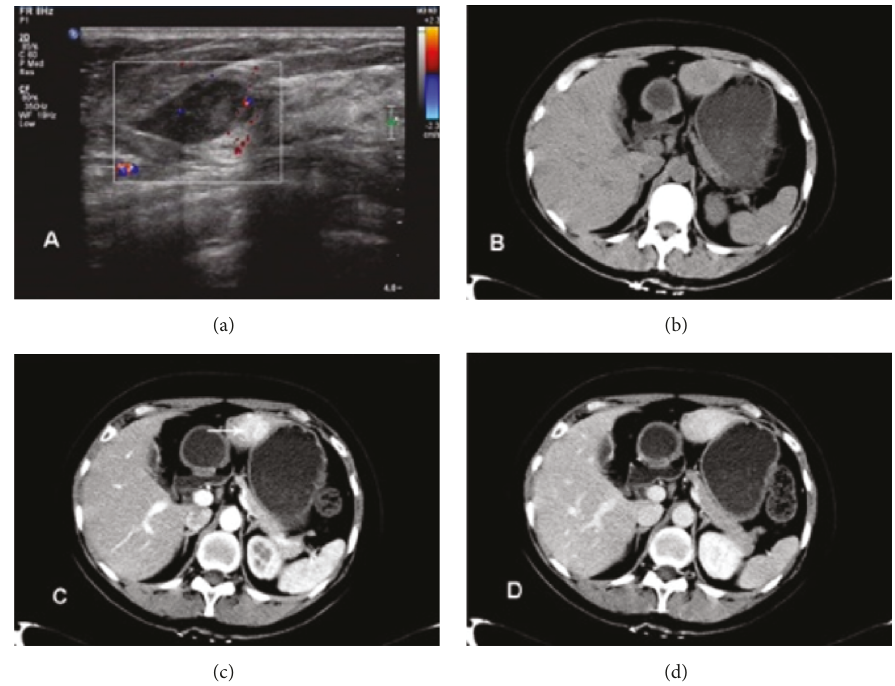
Figure 2: Abdominal ultrasonography (USG) and CT findings: (a) USG shows a 3 × 3cm slightly hypoisoechoic hepatic lesion in left lateral lobe with slightly unclear borders and blood flow signal; (b) plain CT shows that the lesion is lobulated, homogeneous, and isointense compared to surrounding liver parenchyma; (c) enhanced CT shows that hypervascular lesion appears hyperdense with a slightly hypodense central scar in the arterial phase (arrows); (d) in the portal venous phase the lesion is isodense without signs of central